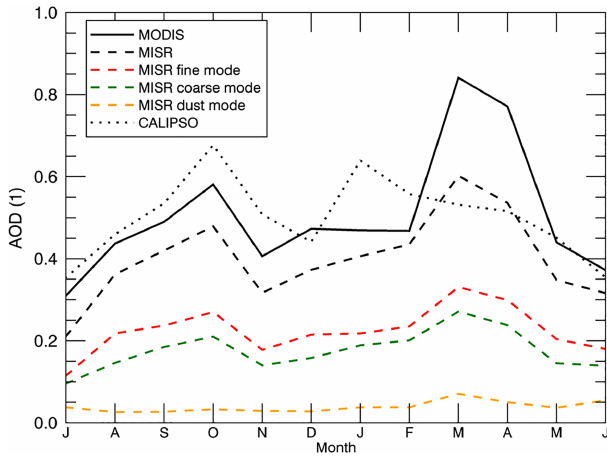
Figure 1. Seasonal variation in aerosol optical depth over southern China, based on the period 2006–2015, from MODIS, MISR and CALIPSO, including MISR fine- and coarse-mode and dust particle AOD. Note that the horizontal axis starts in July and ends in